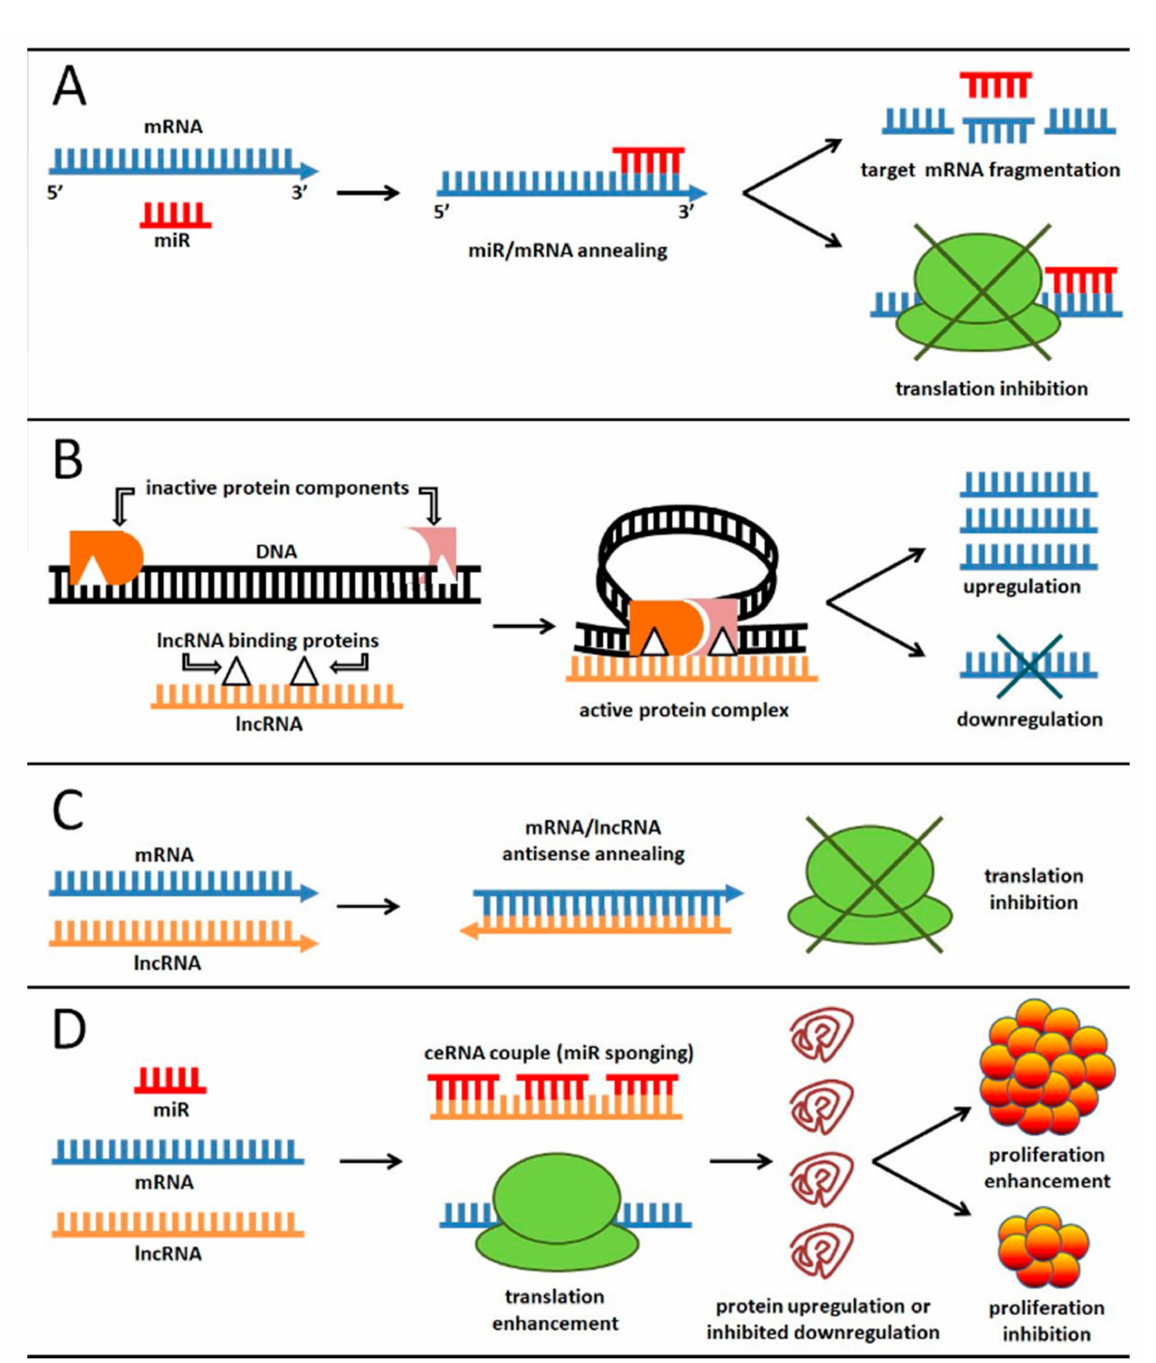
Figure 1. Schematic representation of the most common ncRNA functions in cells. In all panels, the target genes may be either oncogenes or oncosuppressors, depending on the ncRNA involved and the mRNA target; as such, any of the described mechanisms may enhance or inhibit cell proliferation. ( A ): miR-mediated post-transcriptional control of gene expression; miR can pair with target mRNA through sequence homology and promote either mRNA fragmentation or translation impairment. ( B ): gene expression control of lncRNA through DNA structure modification; in this case gene expression is regulated at the transcriptional level. ( C) : gene expression control of lncRNA through antisense annealing; in this case gene expression is regulated at the post-transcriptional level. ( D) : lncRNA and mRNA compete for the miR binding; in this case the lncRNA may sponge the miR(s) and allow mRNA translation. See text for additional explanations. Blue, mRNA; red, miR (sncRNA); orange, lncRNA; black, DNA; green, ribosome; other colors/forms, proteins. List of abbreviations: sncRNA is short non coding RNA; miR is micro RNA; lncRNA is long non coding RNA; ceRNA is competing endogenous RNA; mRNA is messenger